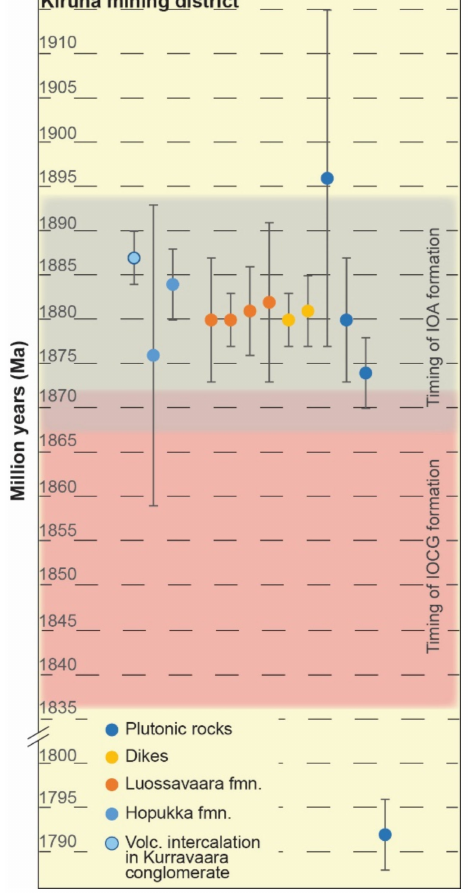
Figure 3. Summary of U-Pb (ICP–MS and SIMS zircon and titanite) geochronology data on volcanic– plutonic rocks in the Kiruna mining district. Gray and red shadows mark approximate time boundaries of IOA and IOCG formation in the Kiruna mining district, respectively. Data from